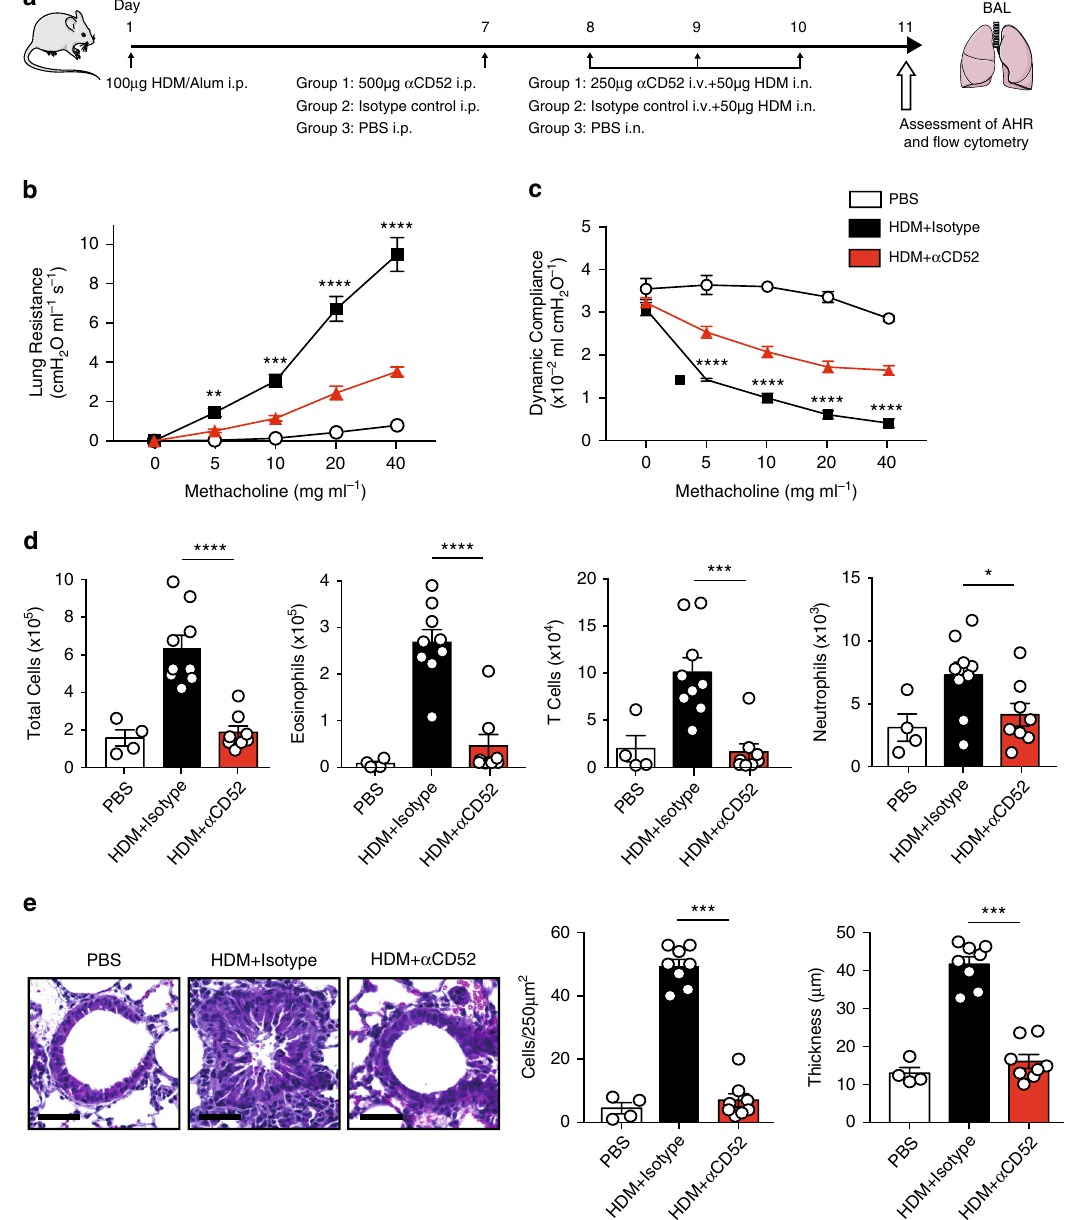
Fig. 5 Effect of an anti-CD52 antibody on lung function and in fl ammation in mice. a The experimental protocol for testing the effect of a mouse anti- CD52 ( α CD52) antibody on pulmonary function and in fl ammation was designed to mimic the clinical protocol used to treat multiple sclerosis patients with a human α CD52 antibody (alemtuzumab). Female BALB/cByJ mice were immunized on day 1 with 100 µ g of house dust mite (HDM) in 2 mg of aluminum hydroxide (alum) by intraperitoneal (i.p.) injection. On day 7, mice were intraperitoneally administered with 500 µ g of either the α CD52 antibody (Group 1, red bars; n = 8) or isotype control antibody (Group 2, black bars; n = 9), or phosphate-buffered saline (PBS) (Group 3, white bars; n = 4). On days 8, 9 and 10, mice in Groups 1 and 2 were intravenously (i.v.) administered 250 µ g of the α CD52 antibody or isotype control antibody, respectively, and simultaneously challenged intranasally (i.n.) with 50 µ g HDM. Mice in Group 3 were only challenged with PBS i.n. on days 8, 9, and 10. On day 11, lung function was measured by invasive plethysmography and leukocyte counts were determined in bronchial alveolar lavage (BAL) by fl ow cytometry. Compared to HDM-exposed mice receiving the control isotype antibody, HDM-exposed mice administered the α CD52 antibody had signi fi cantly reduced lung resistance ( b ) and improved dynamic compliance ( c ). HDM-exposed mice receiving the α CD52 antibody also had signi fi cantly decreased numbers of total cells, eosinophils, T cells, and neutrophils in BAL ( d ) as well as decreased in fl ammation and thickness of the airway epithelium ( e ) compared to HDM- exposed mice injected with the isotype control antibody. Scale bars equal 50 μ m. Data are shown as mean ± SE and derived from two independent experiments yielding similar results. Two-tailed unpaired Student ’ s t -tests were used to determine statistically signi fi cant differences between groups. * P < 0.05, ** P < 0.005; *** P < 0.0005; **** P <